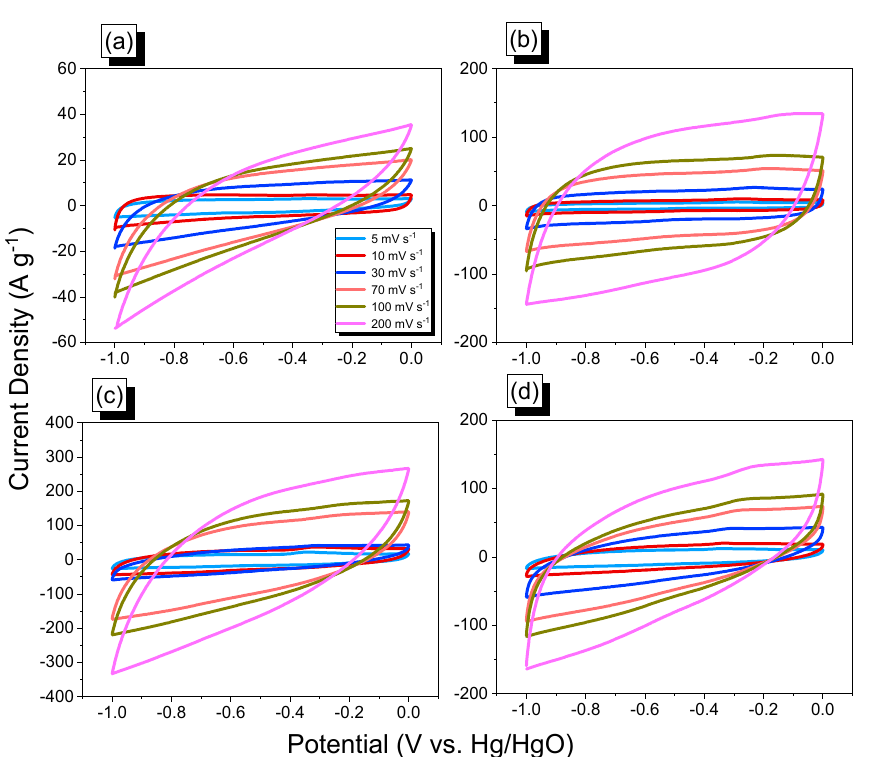
Figure 7. Cyclic voltammetry profiles of An-CTF-10-400 ( a ), An-CTF-20-400 ( b ), An-CTF-10-500 ( c ), and An-CTF-20-500 ( d ). Figure 8a–d show the GCD curves of An-CTFs samples recorded at different current densities ranging from 0.5 to 20 A·g − 1 . The An-CTFs sample GCD curves displayed tri- angular forms with a small bend, indicating both pseudo-capacity and EDLC features [54, 55 ]. As shown in Figure 8c,d, the discharging time of An-CTF-10-500 was longer than that of the An-CTF-20-500, showing that the former ’ s capacitance was greater than that of the latter.